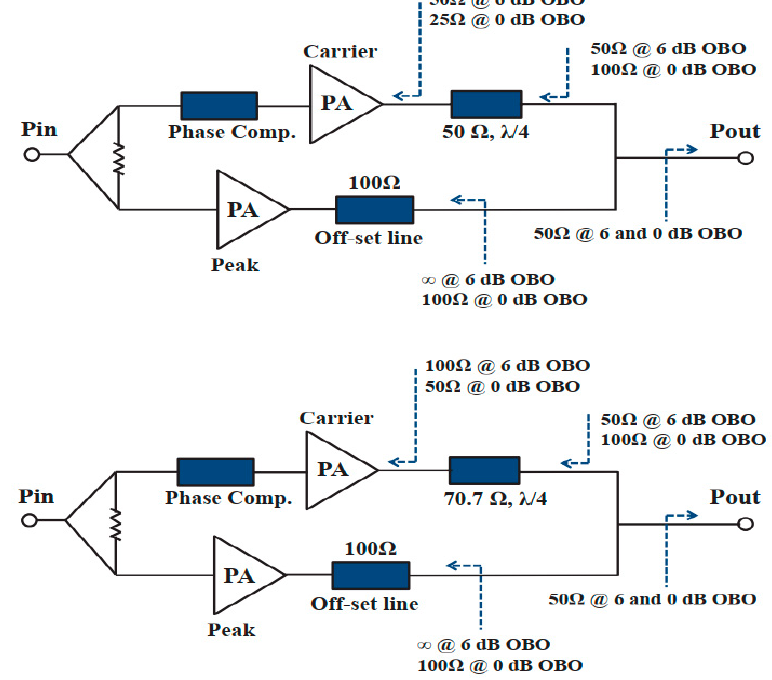
Figure 11. Simplified structure of DPA [34].